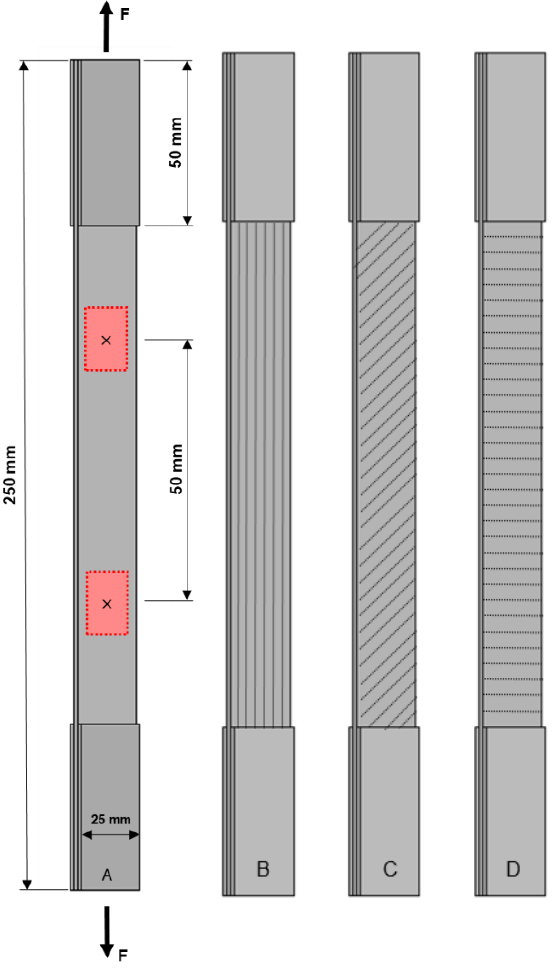
Figure 1. ( A ) Sample geometry and schematical depiction of the test setup for strength and stiffness measurements following DIN 52 188 [36] and DIN EN 789 [37], where the gauge length and laser pattern are marked in red and where the reference point for the strain measurement is marked with “x”; ( B ) fibre orientation for 0 ◦ load angle measurements ( σ 0 and E 0 ); ( C ) fibre orientation for 45 ◦ load angle measurements ( σ 45 and E 45 ); and ( D ) fibre orientation for 90 ◦ load angle measurements ( σ 90 and E 90 ) (own depiction, not to scale).